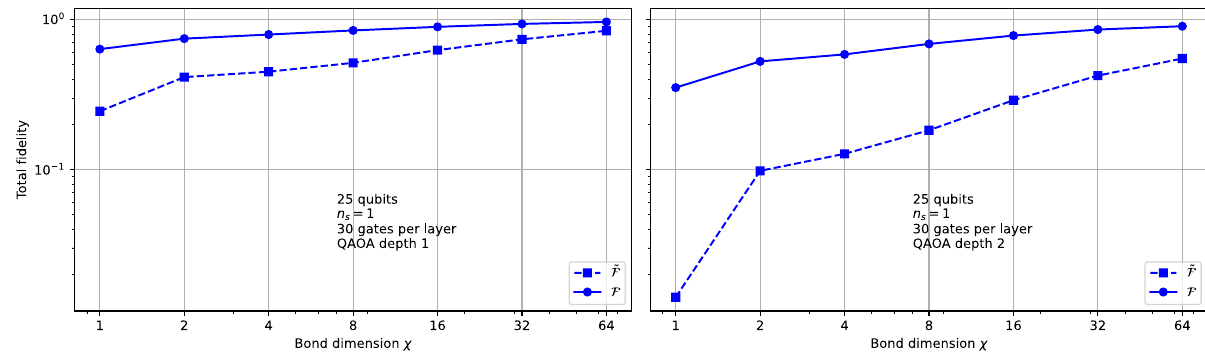
FIG. 11. Comparison of various fidelities for the QAOA circuit. Fidelities as a function of bond dimension χ , at fixed circuit depth [ p = 1 (left) and p = 2 (right)]. Exact fidelity F [Eq. (12)] and product fidelity